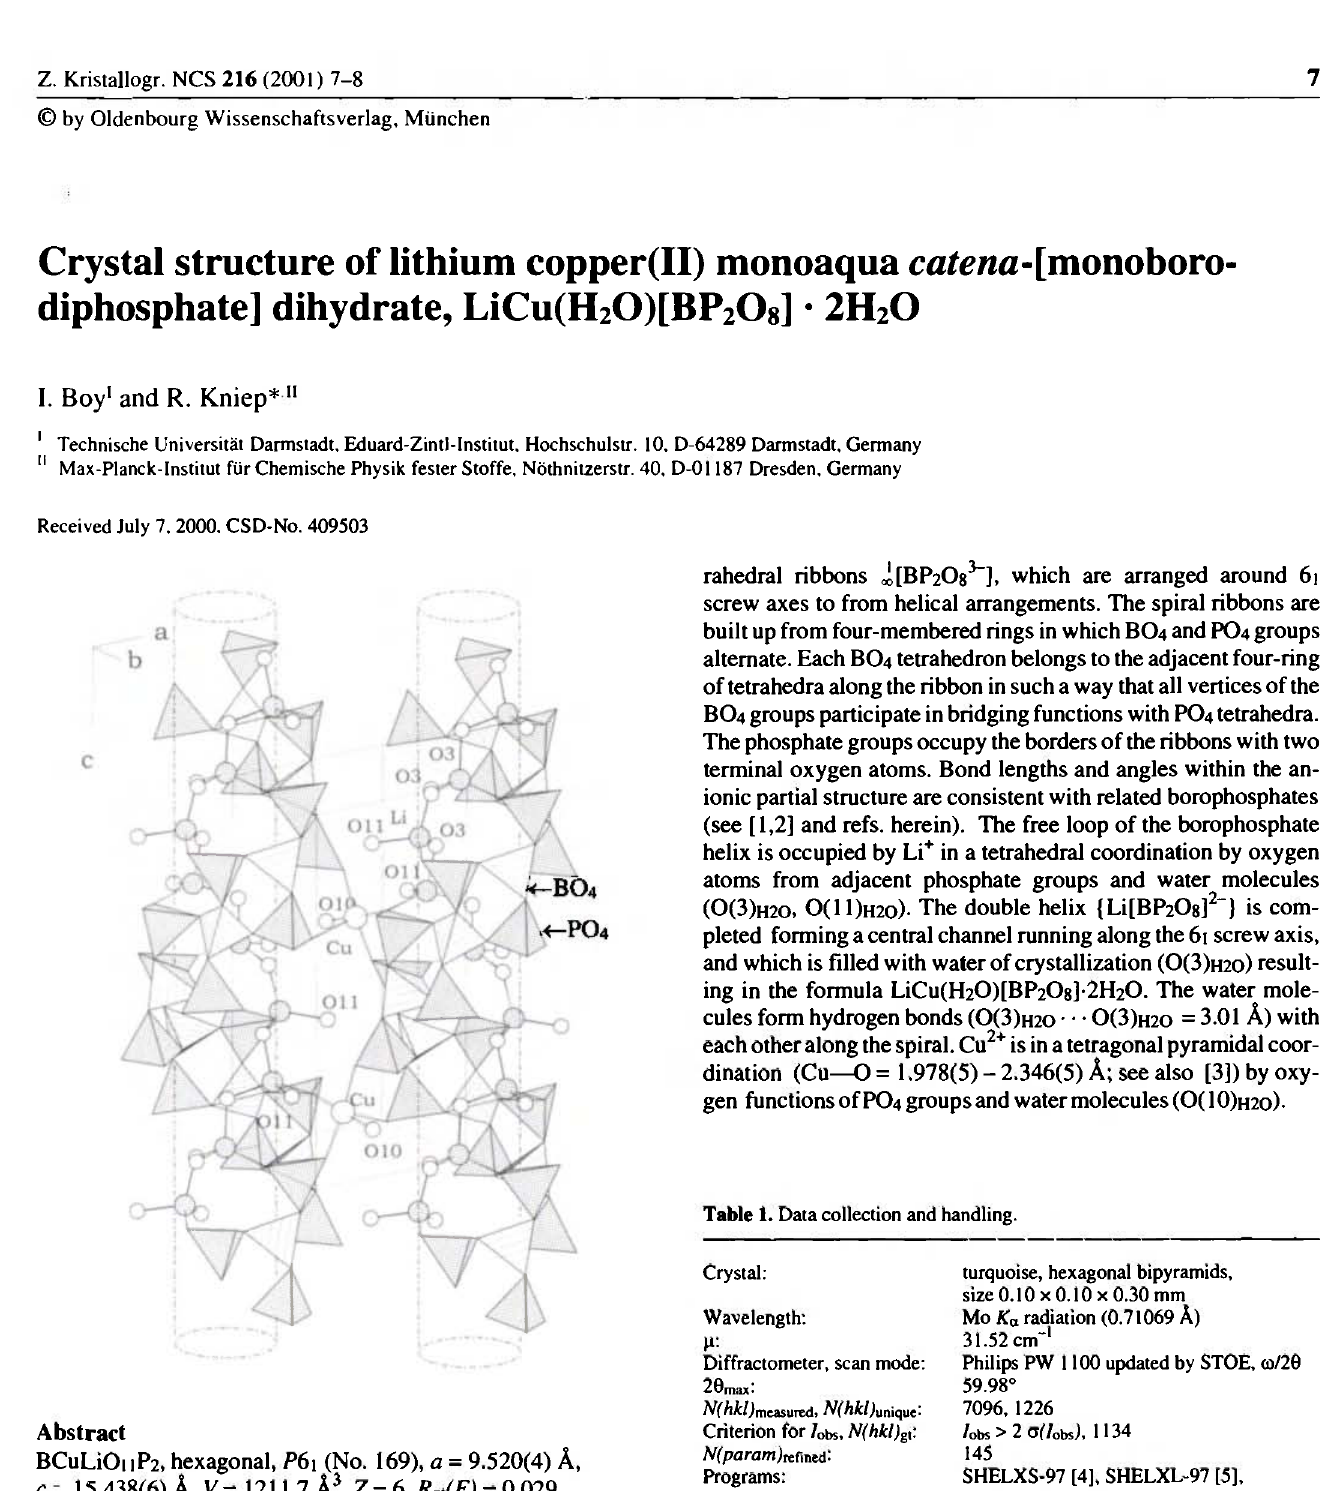
Table 1. Data collection and